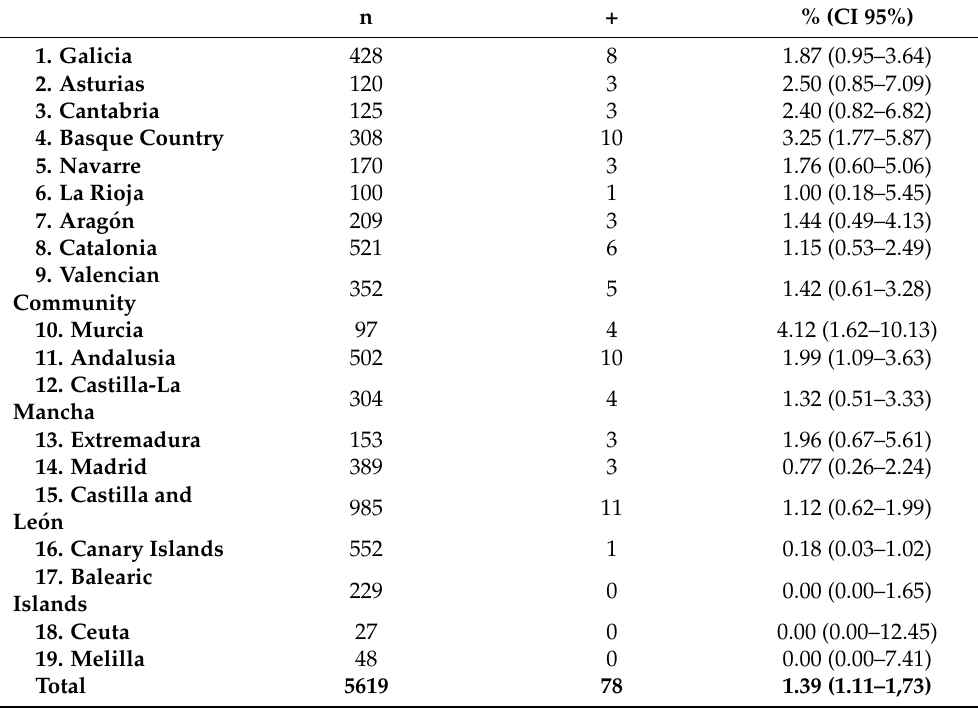
Table 1. Prevalence of A. vasorum in dogs in Spain by autonomous communities and autonomous cities (Ceuta and Melilla). Abbreviations : n, number of dogs sampled; +, number of positive dogs; %, percentage of positive dogs (confidence interval